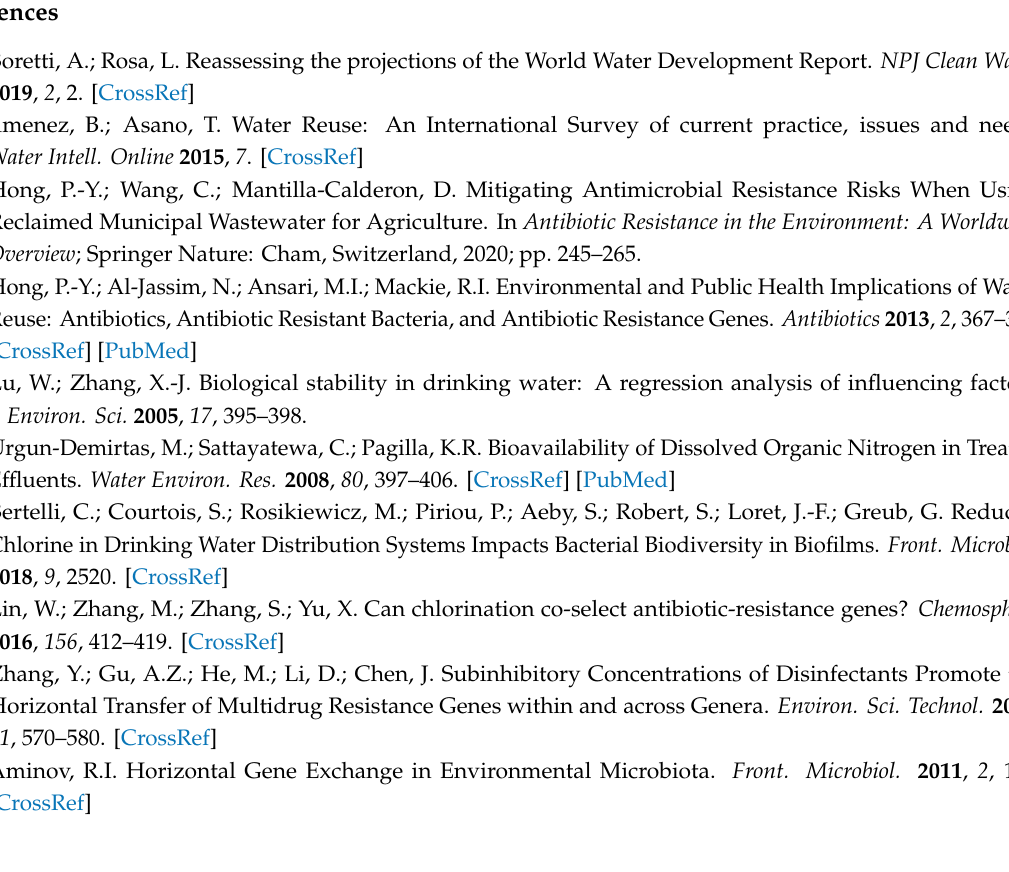
Figure S1: Bacterial community (order level) similarity by sample type and sampling site, Figure S2: Venn diagram depicting the number of unique and shared bacterial orders, Figure S3: Coverage and proportion of detection for ARG across MAGs, Table S1: List of shotgun metagenomics sequenced samples analyzed in this study, Table S2: Average relative abundance of detected bacterial order, Table S3: Correlation coe ffi cient between POU bacterial diversity (Shannon index) with water chemistry, Table S4: List of high quality recovered metagenome-assembled genomes (MAGs), Table S5: List of dereplicated MAGs, Table S6: Classification for MAGs, Table S7: Information on MAGs, Table S8: List of antibiotic resistance genes from MAGs, Table S9: Information on ARGs in MAGs, Table S10: Annotation for mobile genetic elements in MAGs, Table S11: Information on ARG detection in water samples by location, Table S12: Information on ARG coverage and proportion of detection in water